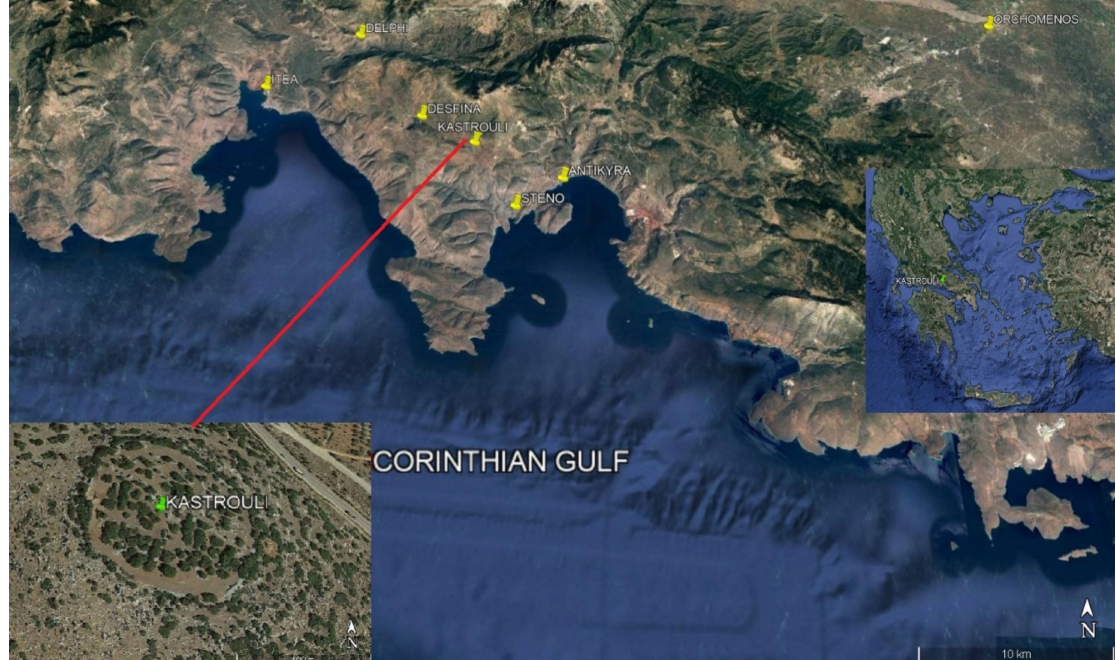
Figure 1. Location of the main sites reported in the text on the map of central Greek mainland. The inset picture is an oblique aerial view of the Kastrouli settlement (coordinates: 37 ◦ 54 (cid:48) 19.56 E, 42 ◦ 50 (cid:48) 792.35 N; Google